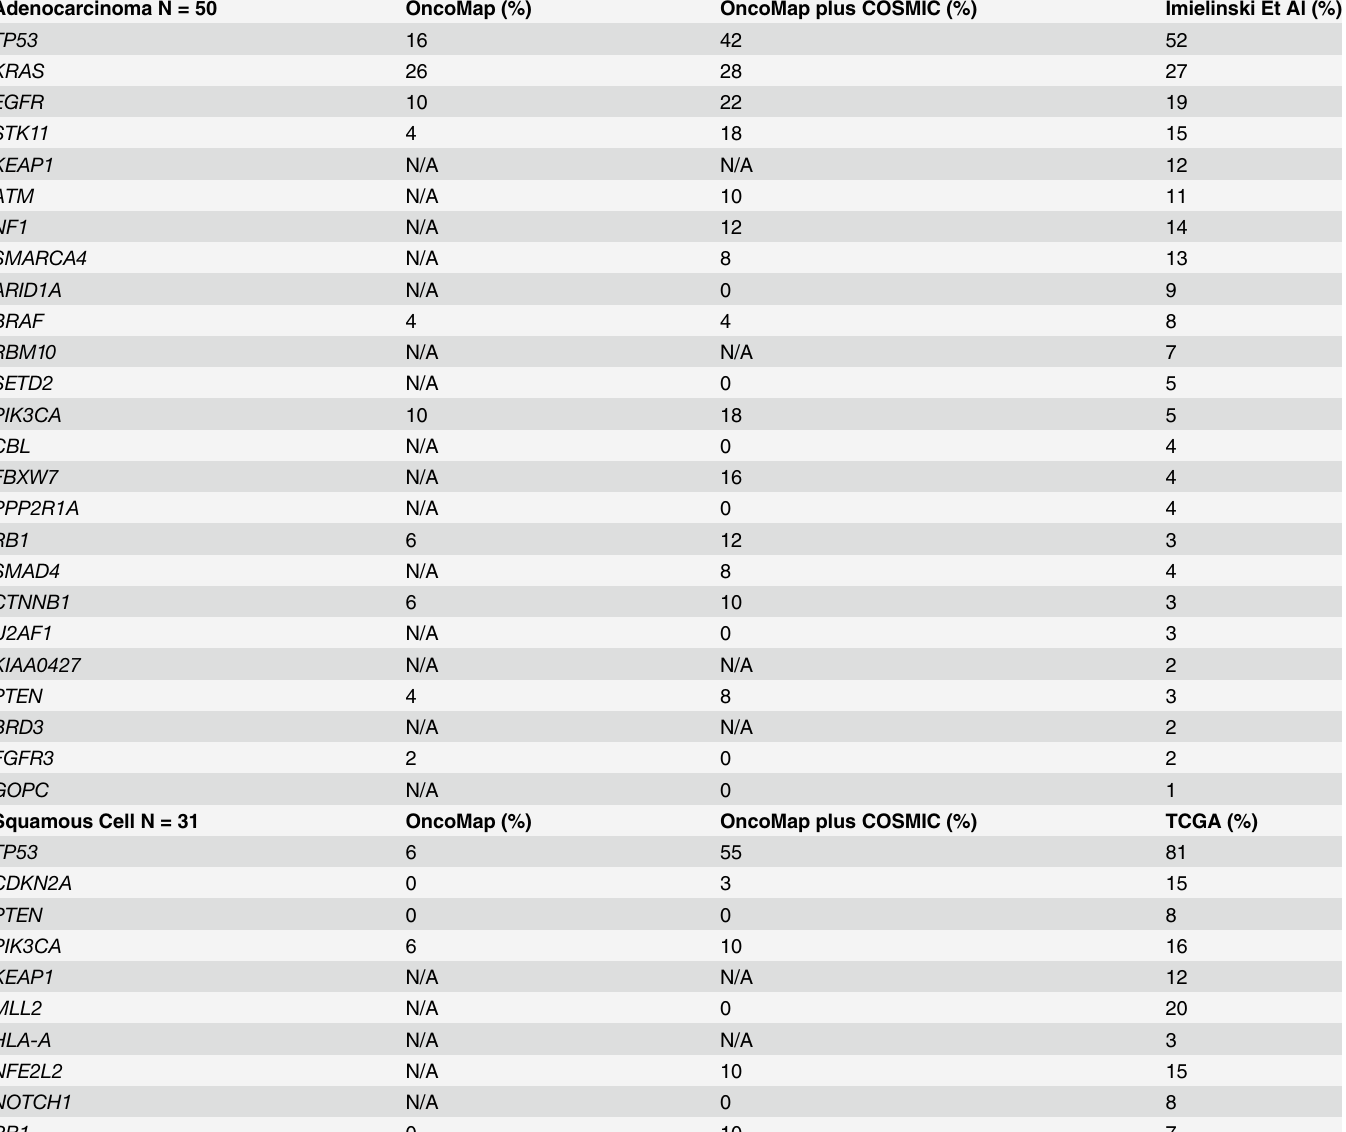
Table 2. SNV Calling (07 – 0120 Cohort) Using Two Different SNV Databases (OncoMap ± COSMIC) for the 2 most frequent histologic lung cancer types, adenocarcinoma and squamous carcinoma. Adenocarcinoma N = 50